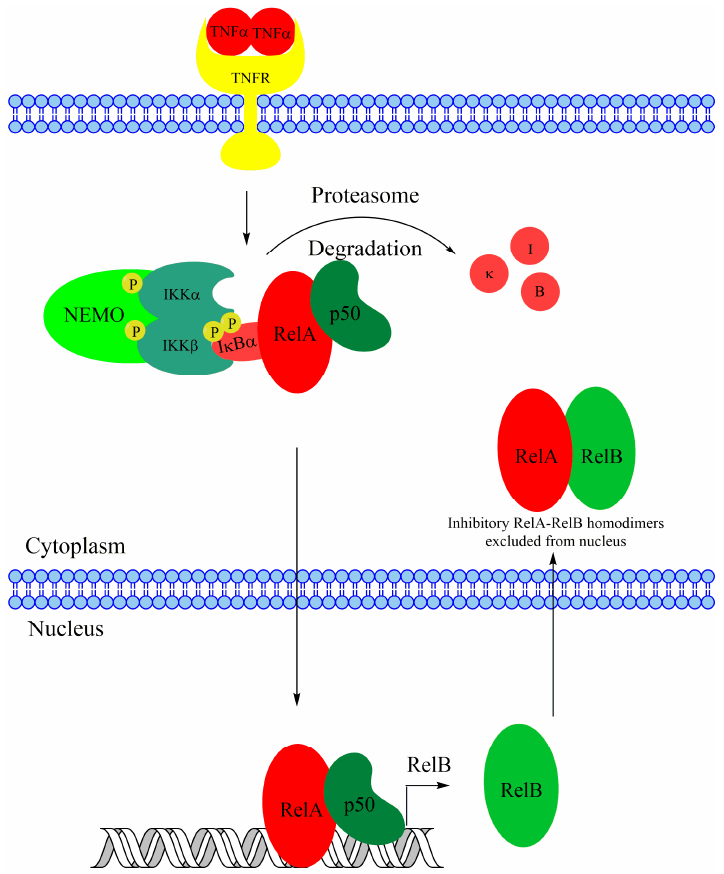
Figure 5. Canonical NF- κ B activity stimulates RelB expression. Activation of RelA-p50 dimers with TNF α induces increased expression of RelB. RelB induction serves as negative feedback by binding RelA and sequestering it in the cytoplasm.